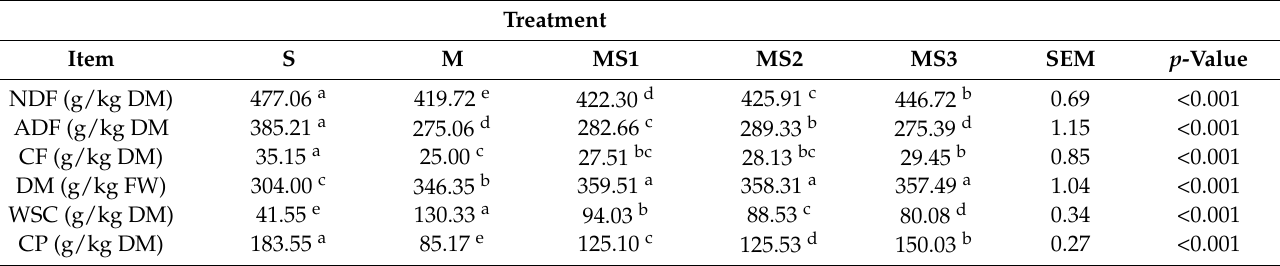
Table 2. The main chemical composition of different treatments before ensiling. Treatment